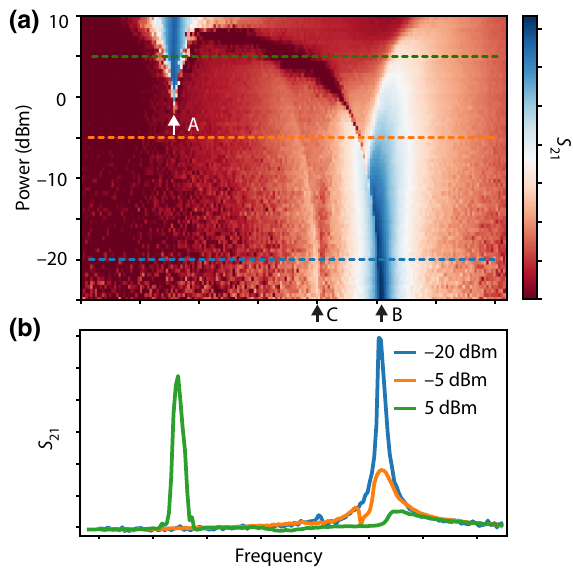
FIG. 10. Resonator power scan . (a) Outcome of cavity spec- troscopy experiments repeated at different input powers. The three features of interest are indicated by the arrows, corre- sponding to the high-power transmission peak (A), lower power transmission peaks with transmon in ground state (B) and resid- ual excited state (C), respectively. (b) A line cut at three different powers, highlighting the clear shift in resonance frequency of the resonator as it transitions from the high- to low-power